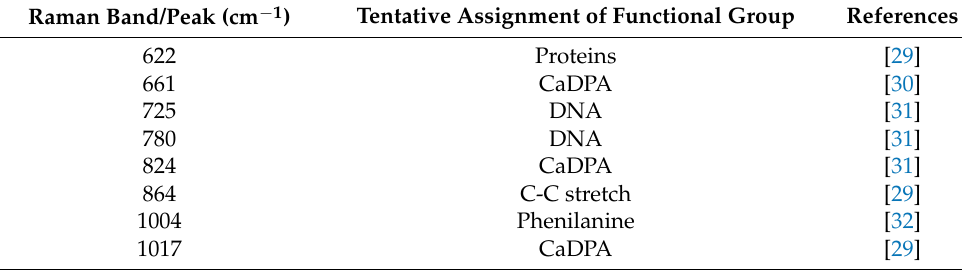
Table 2. Raman bands and the tentative assignment of their functional